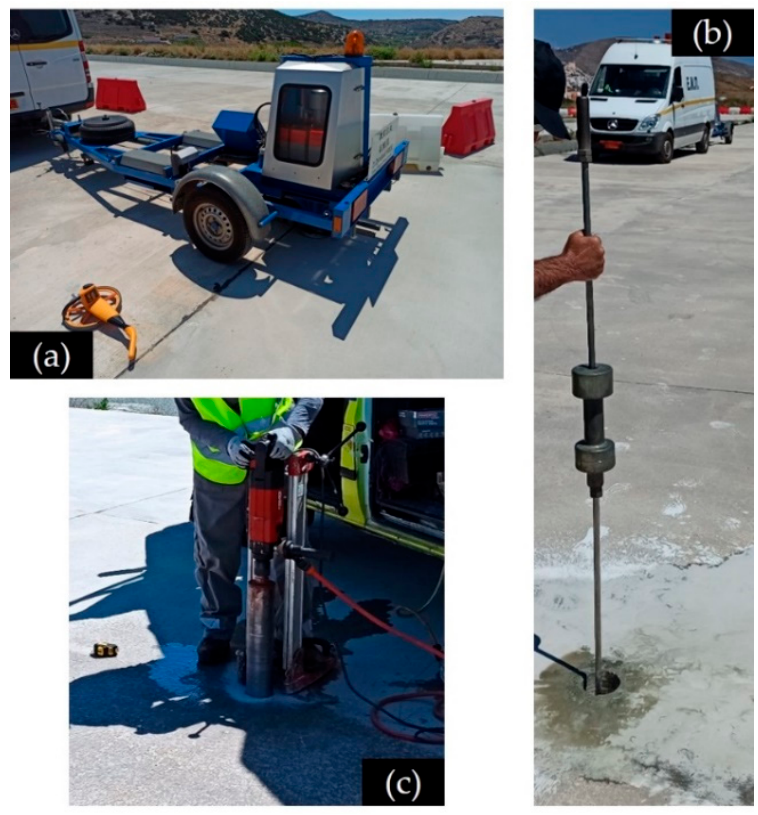
Figure 2. Experimental testing: ( a ) FWD, ( b ) DCP and ( c ) coring.